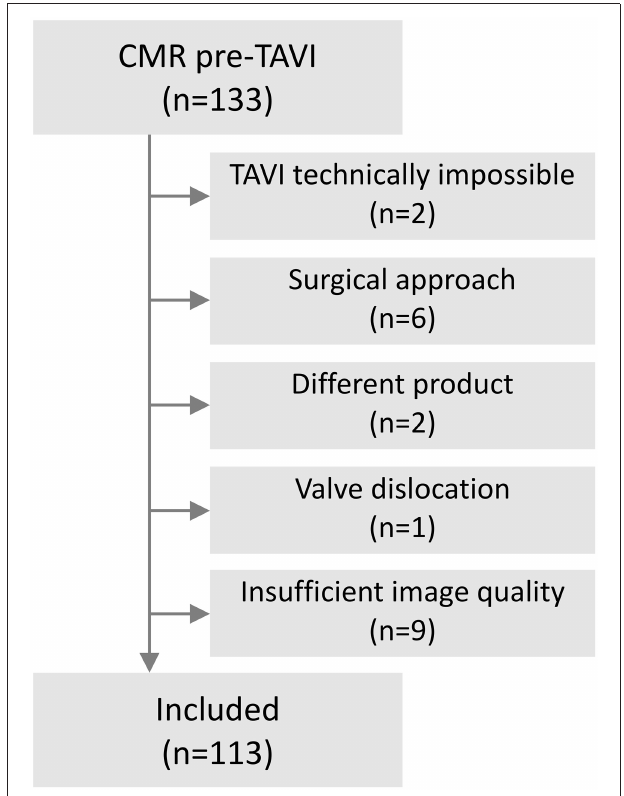
FIGURE 1 | Flow chart of included